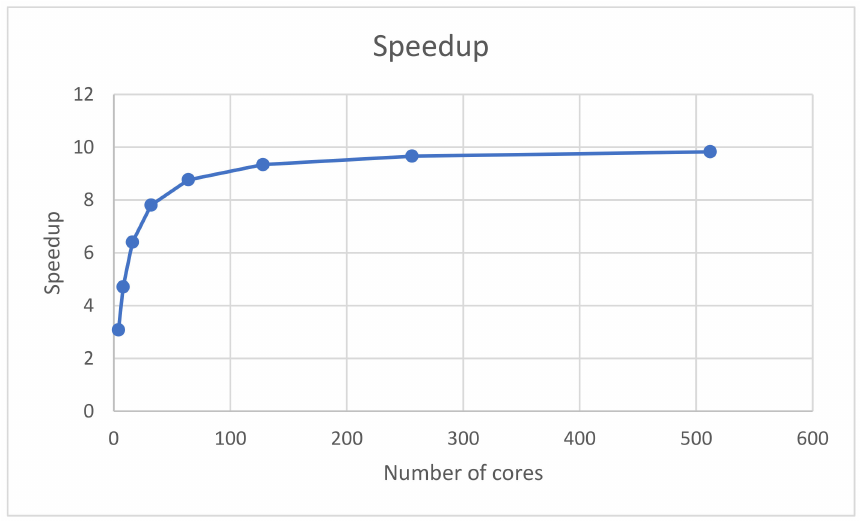
Figure 14. Speedup calculated using Amdahl’s